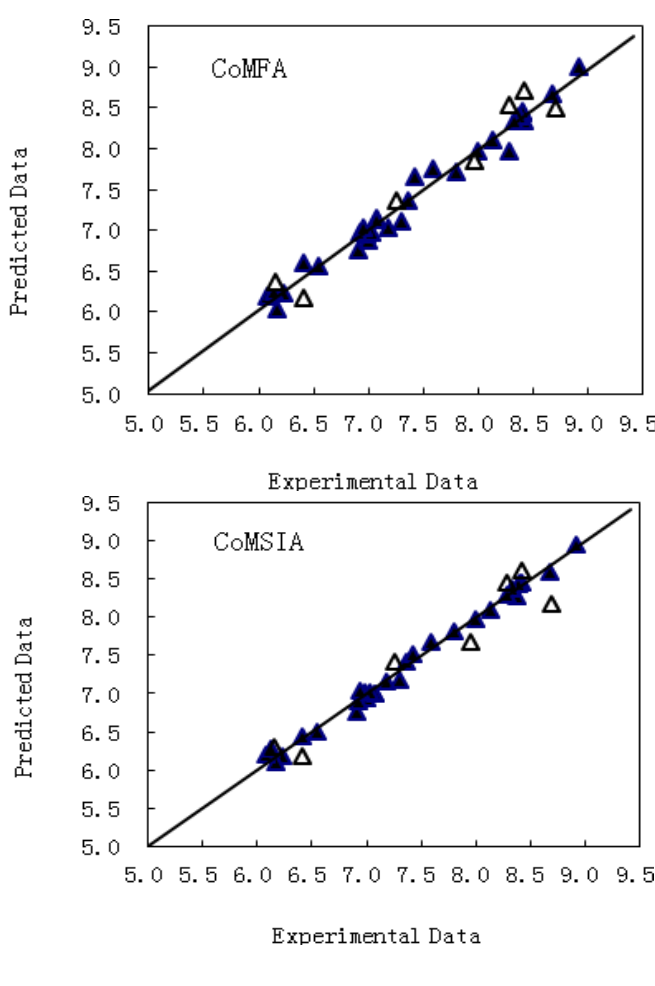
Figure 3. Correlation between the experimental and predicted values of the 3D-QSAR models for the training and test sets. The top figure is the CoMFA model; the bottom one is the CoMSIA model. The training set is shown by the filled triangles; the test set is shown by the empty